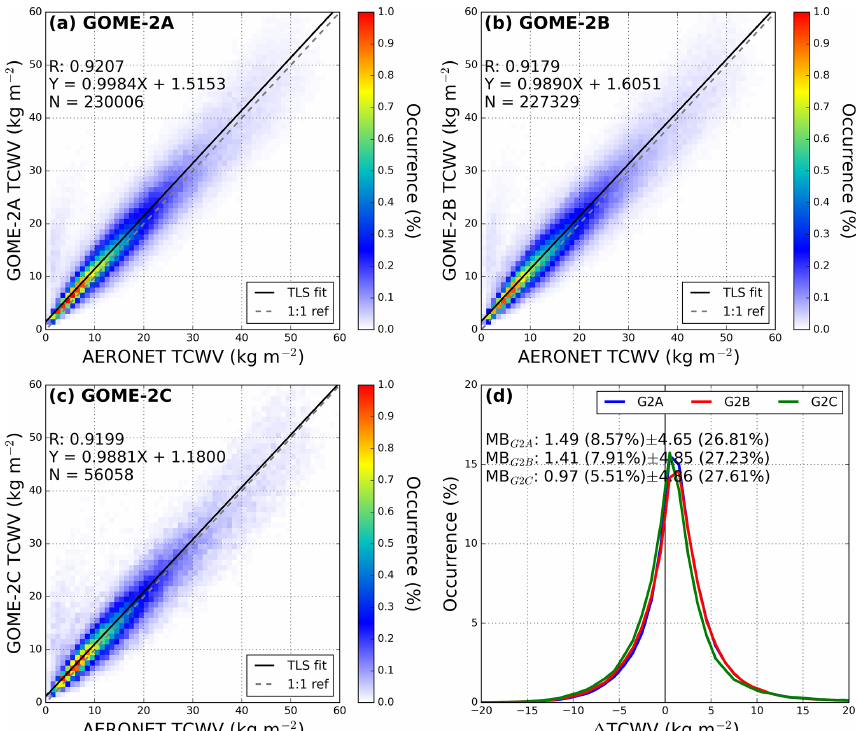
Figure 19. Comparison of daily total column water vapour measured by the sun photometer to (a) GOME-2A, (b) GOME-2B, and (c) GOME-2C. Histograms of the difference between GOME-2 and the sun-photometer are shown in panel (d) . Co-located daily averaged data are used in the